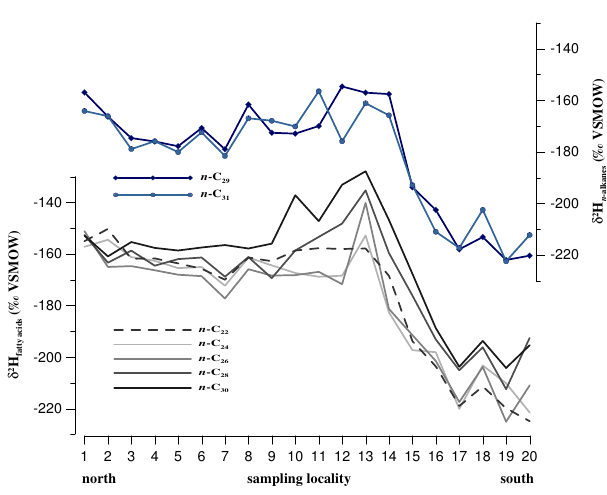
Figure 2. Comparison of δ 2 H results of individual leaf wax n - alkanes and n -alkanoic (fatty) acids along the investigated